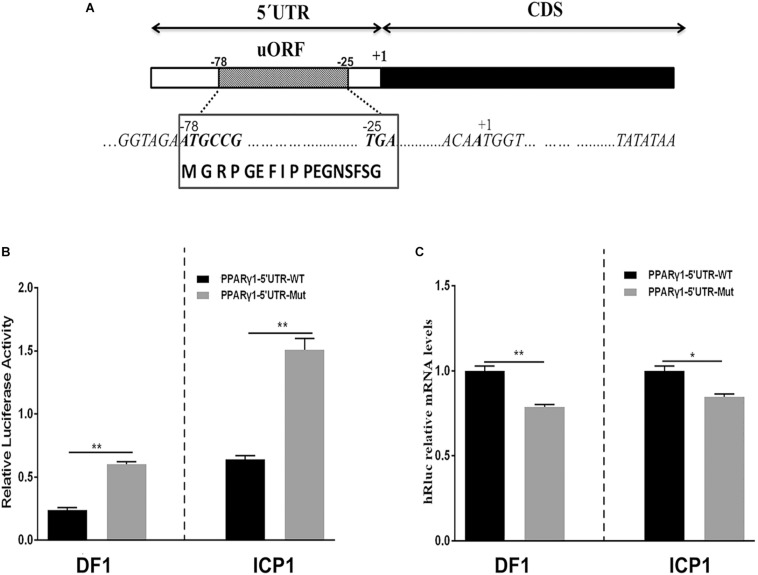
Schematic representation of PPARγ1 5′ UTR and effects of the PPARγ1 uORF mutation on Rluc luciferase activity and mRNA expression. (A) A schematic diagram of the 117-nucleotide-long PPARγ1 5′ UTR, the uORF is from nucleotides –78 to –25 of the 5′ UTR, and indicated by a striped rectangle. All positions are numbered relative to the initiation codon AUG of PPARγ transcript 1, where A is +1. The uORF encodes a 17-amino acid peptide with the amino acid sequence shown in the bottom. (B) The effect of uORF mutation on the luciferase reporter gene activity. The wild-type (PPARγ1-5′UTR-WT) and uORF mutant (PPARγ1-5′UTR-Mut) PPARγ1 5′ UTR reporter constructs were transfected into ICP1 and DF1 cells, respectively, and reporter gene activity was measured. Compared with the wild-type PPARγ1 5′ UTR reporter, the luciferase activity of PPARγ1-5′UTR-Mut was significantly higher than that of PPARγ1-5′UTR-WT in both ICP1 and DF1 cells (n ≥ 3, **P < 0.01, Student’s t-test). (C) The Rluc mRNA quantification by real-time RT-PCR in the ICP1 and DF1 cells transfected with the indicated reporter constructs. The relative Rluc mRNA levels are normalized to the expression levels of the cells transfected with the reporter PPARγ1-5′UTR-WT. Data were expressed as the mean ± SEM, NONO was used as the internal mRNA control. n ≥ 3, *P < 0.05; **P < 0.01, Student’s t-test.